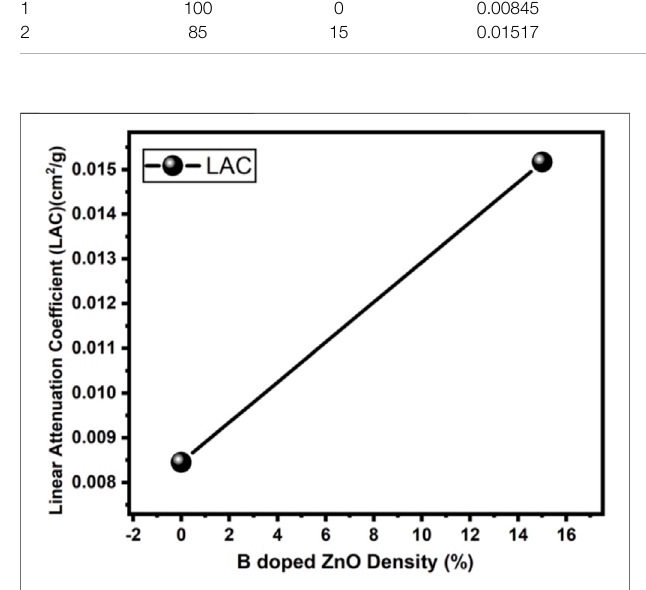
FIGURE11| MassattenuationCoef fi cient ofBdopedZnO(0and